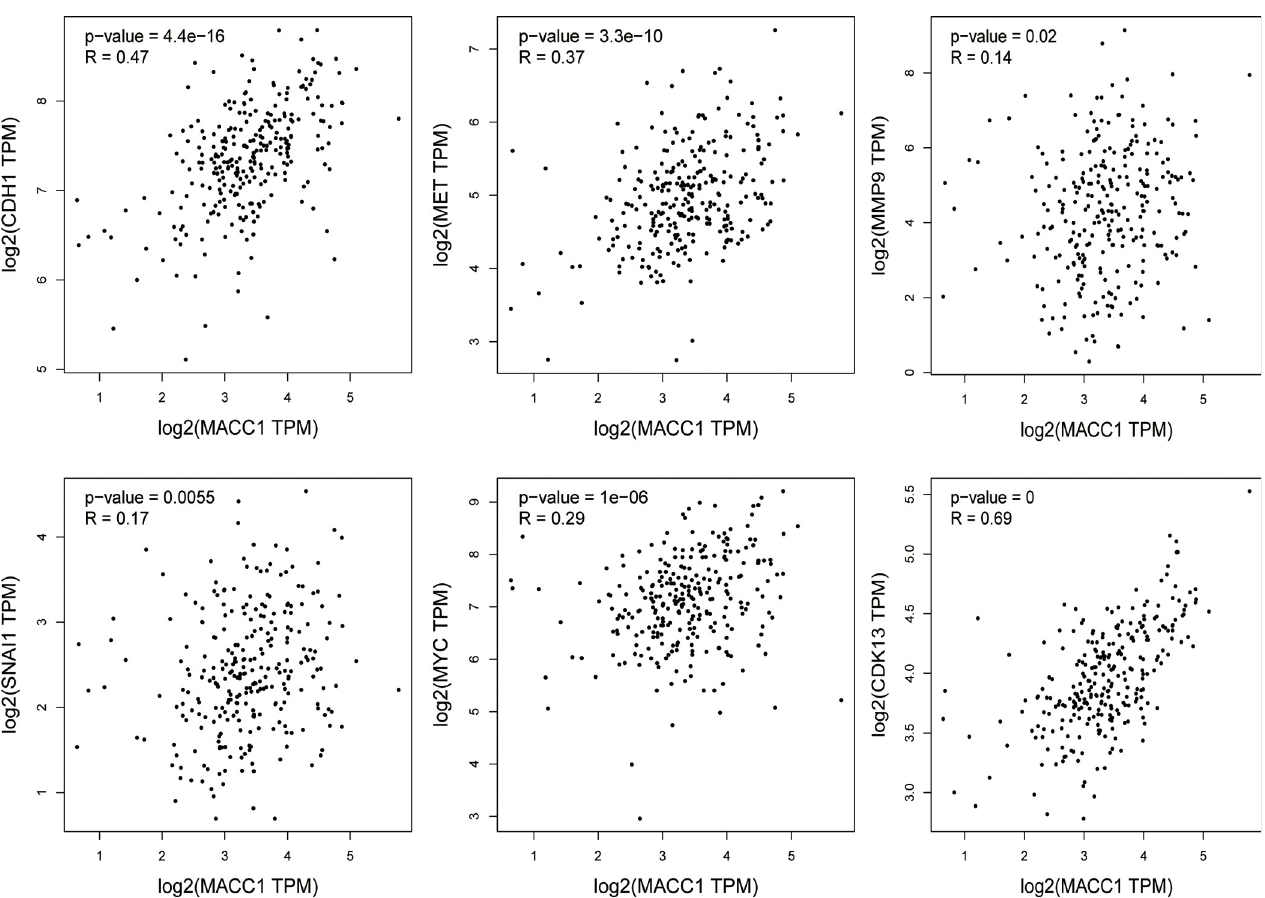
Fig 3. Bioinformatics analysis of MACC1 co-expression genes. Pearson’s correlation analysis of MACC1 and related genes. We used the services provided by the website GEPIA (http://gepia.cancer-pku.cn/index.html) to examine the correlations between CDH1, MET, MMP9, SNAI1, MYC and CDK13.